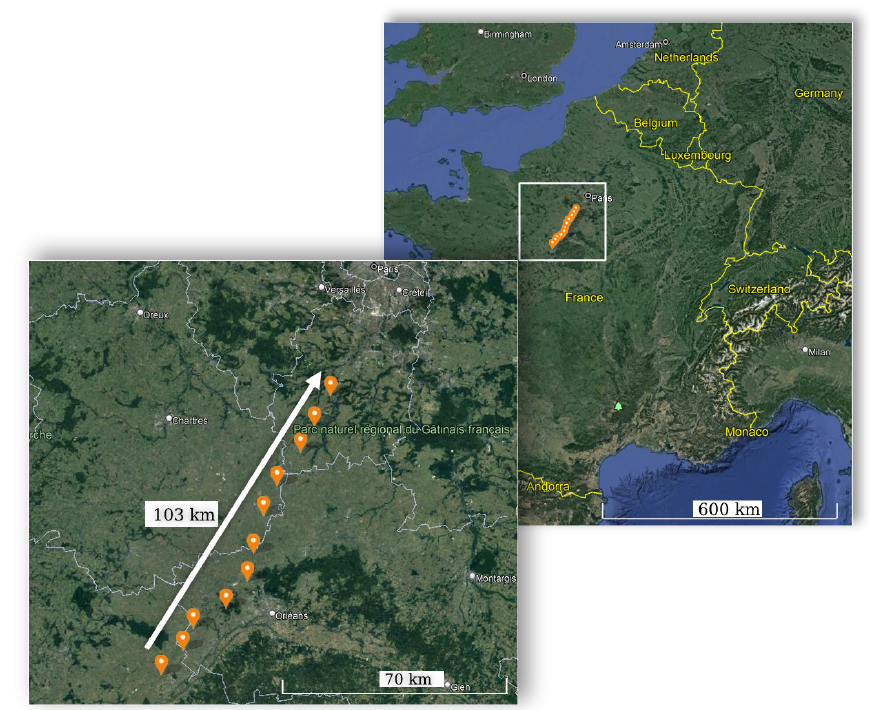
Figure 7. Location of the experiment in the southwest of Paris.